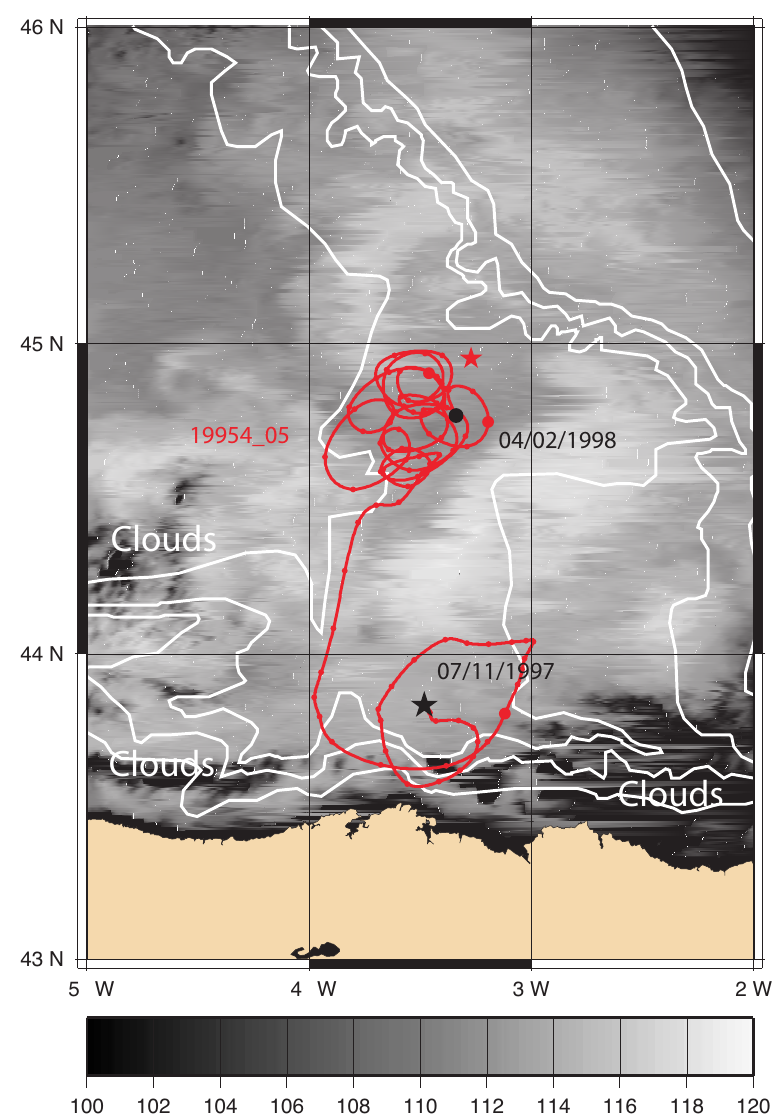
F IG . 7. – Low-pass filtered trajectory of Marvor 19554 (red, cycle 5) superimposed on AVHRR satellite image (IR Channel 4) of 6 February 1998 03:44 UTC. Image is coded in radiance counts (dark shades are cold and light shades warm). Float deployment location is indicated